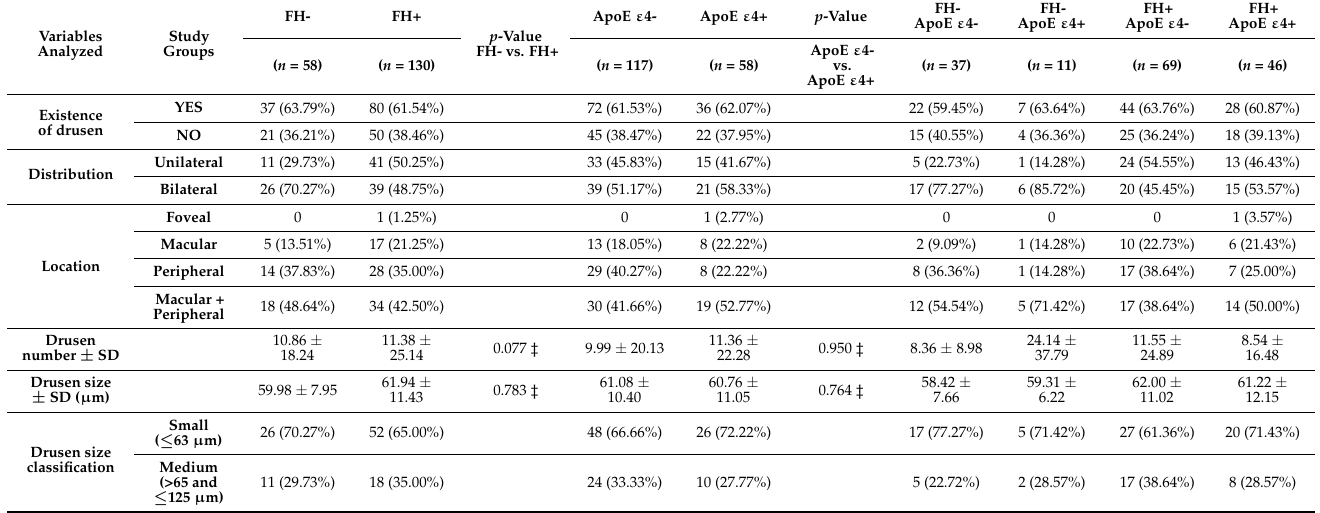
Table 2. Characterization of drusen in subjects according to family history of AD and ApoE